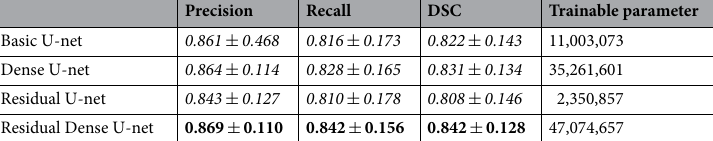
Precision Recall DSC Trainable